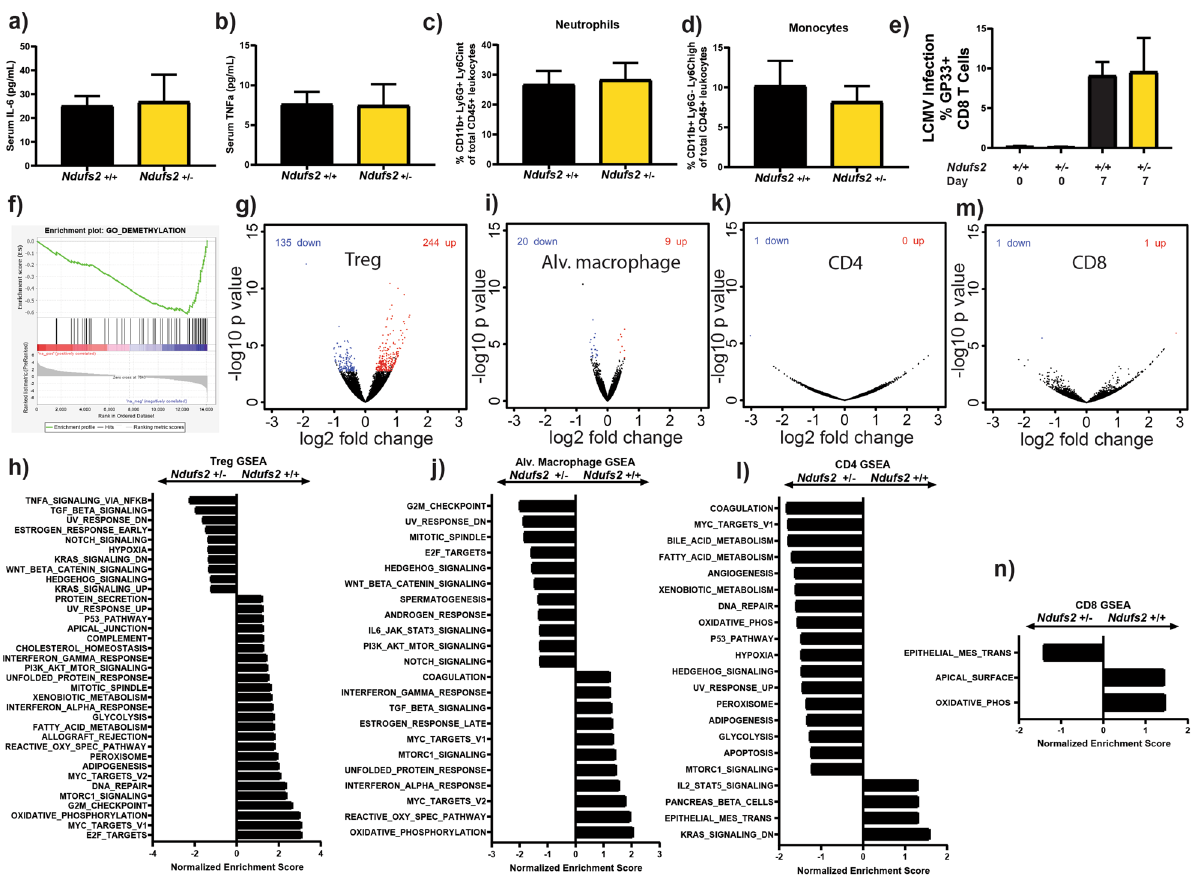
Figure 3. Ndufs2 hemizygosity alters gene expression in immune cell populations. ( a ) Serum IL-6 measurement in 24 month-old mice. n = 4, unpaired t-test p = 0.8919. ( b ) Serum TNFa measurement in 24 month-old mice. n = 4, unpaired t-test p = 0.9616. ( c ) Leukocyte percentage of circulating neutrophils in 27-month-old mice. n = 4, unpaired t -test p = 0.8313. ( d ) Leukocyte percentage of circulating monocytes in 27-month-old mice. n = 4, unpaired t -test p = 0.6048. ( e ) Lymphocytic choriomeningitis virus (LCMV) infection response at 20 months of age. Percentage of GP33 responsive CD8 T cells at day 0 and day 7. n = 4, unpaired t -test p = 0.9204. ( f ) Regulatory T cell GSEA. Demethylation gene set is the top gene ontology biological process gene set enriched in Ndufs2 +/- compared to Ndufs2 +/+ at 20 months of age. ( g , h ) Regulatory T cells differential gene expression analysis in 20-month-old mice. ( g ) Volcano plot individual gene FDR cutoff 0.05, n = 4 ( h ) GSEA significant MSigDB hallmark gene sets with FDR cutoff of 0.25, n = 4. ( i , j ) Alveolar macrophage differential gene expression analysis. ( i ) Volcano plot individual gene FDR cutoff 0.05, n = 4. ( j ) GSEA significant MSigDB hallmark gene sets with FDR cutoff of 0.25, n = 4. ( k , l ) CD4 cell differential gene expression analysis in 20-month-old mice. ( k ) Volcano plot individual gene FDR cutoff 0.05, n = 4 ( l ) Gene Set Enrichment Analysis (GSEA) Molecular Signatures Database (MSigDB) hallmark gene sets. Significant gene sets with FDR cutoff of 0.25, n = 4. ( m , n ) CD8 cell differential gene expression analysis in 20-month-old mice. ( m ) Volcano plot individual gene FDR cutoff 0.05, n = 4. ( n ) GSEA significant MSigDB hallmark gene sets with FDR cutoff of 0.25, n =